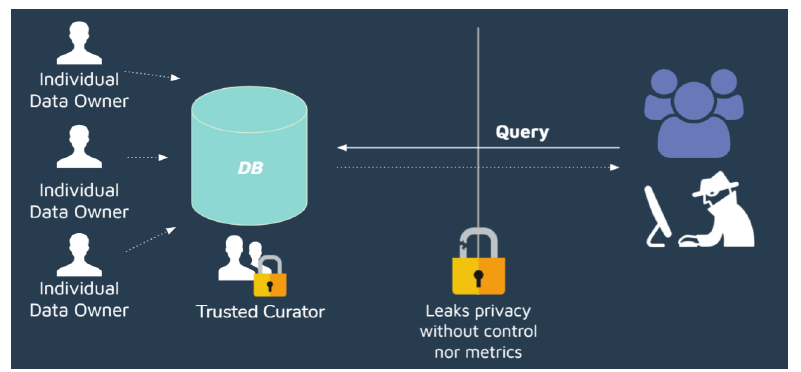
Figure 1. Context without